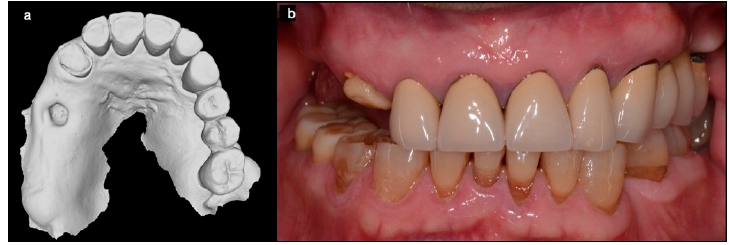
Figure 1. Intraoral digital impression ( a ) and frontal view of the occlusion ( b ).